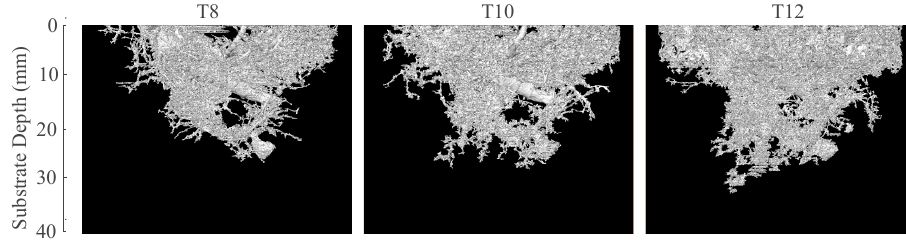
Figure 9. 3D volume of surface-connected Sedum root networks over time, identified from XMT images.